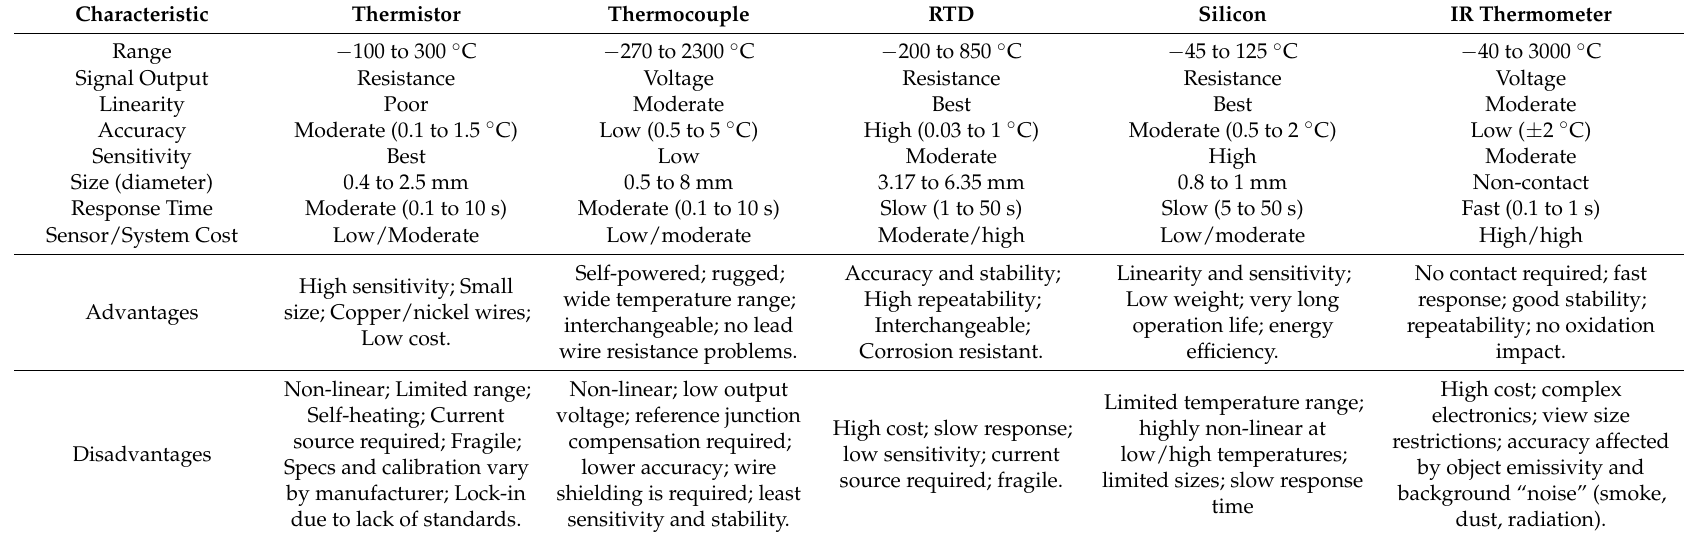
Table 1. Characteristics of temperature sensor